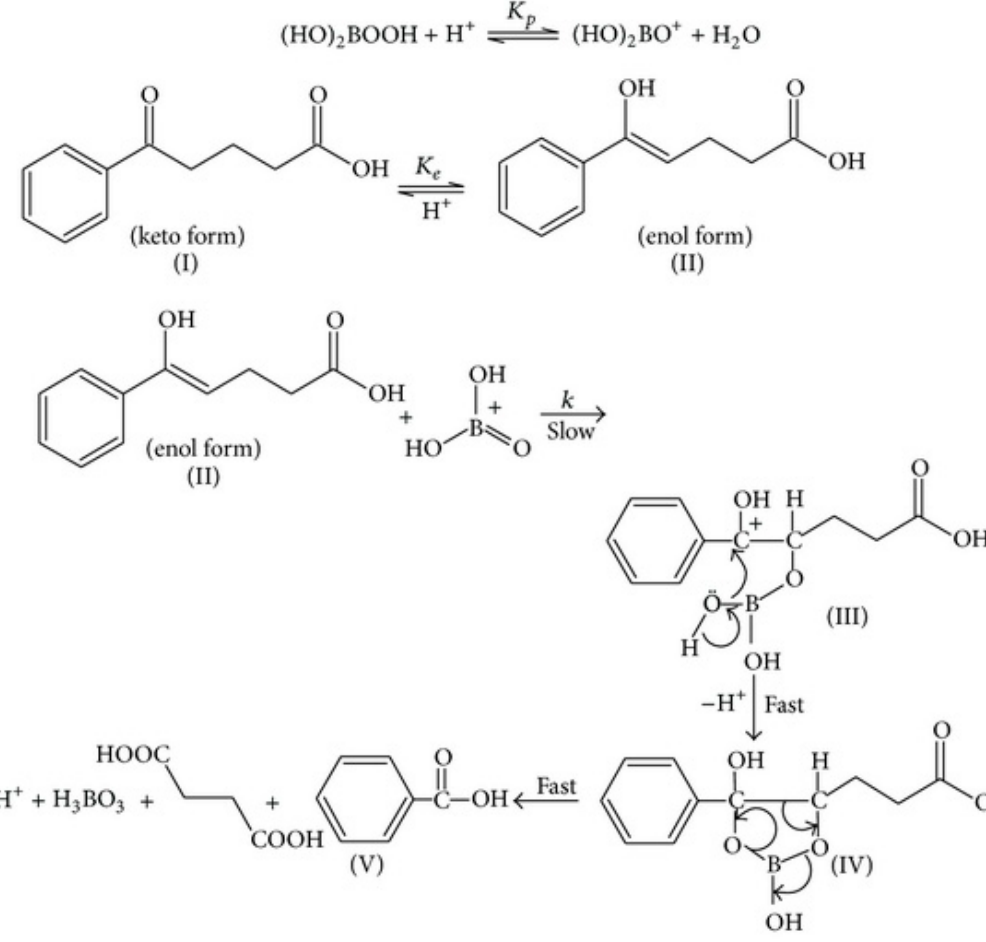
Figure 4. Proposed mechanism for the peroxoborate-mediated oxidation of 5-oxo-acids, which involves a 5-membered ring cyclic intermediate (IV). For this example, benzoic and succinic acids are products. Reproduced from Devi et al. [57] with permission.